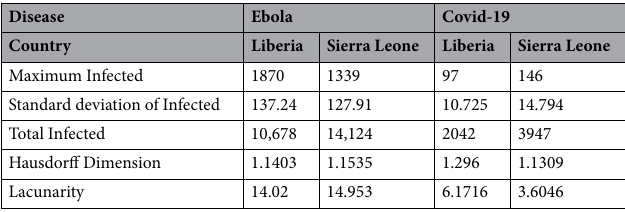
Table 4. Numerical results of diseases based on real